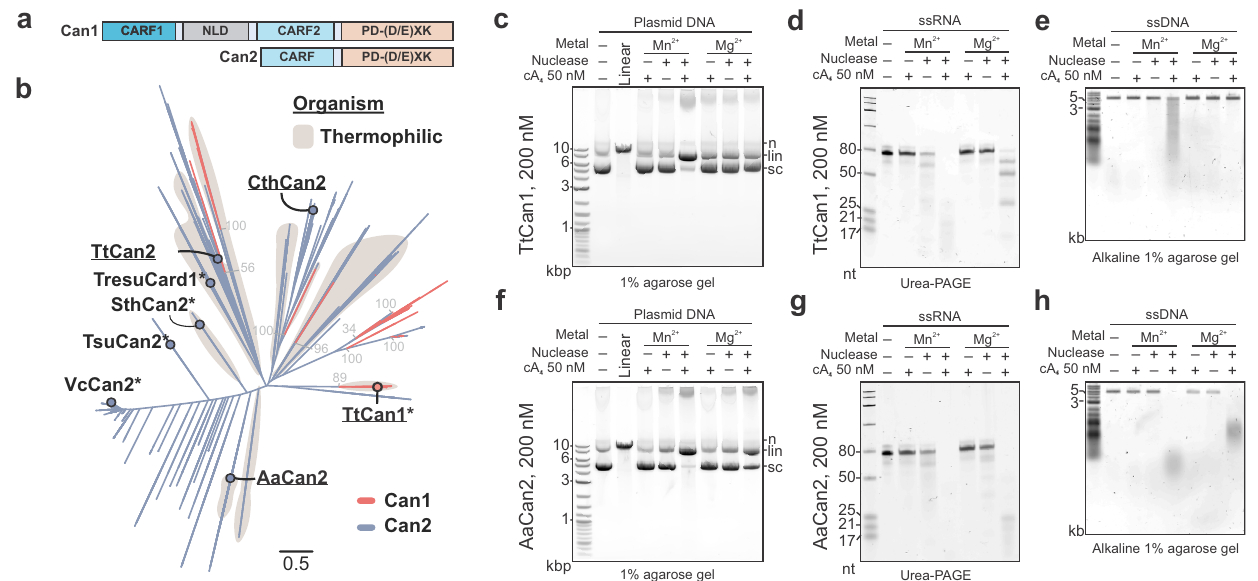
Fig. 2 | Can1 and Can2 ancillary nucleases function as cA 4 -activated nucleases on plasmid DNA, ssRNA, and ssDNA. a Domain organization of Can1 and Can2 proteins. Can2 proteins have two domains – CARF and PD-(D/E)XK superfamily nuclease domain. Can1 is predicted to bederivedfromCan2 by geneduplication 32